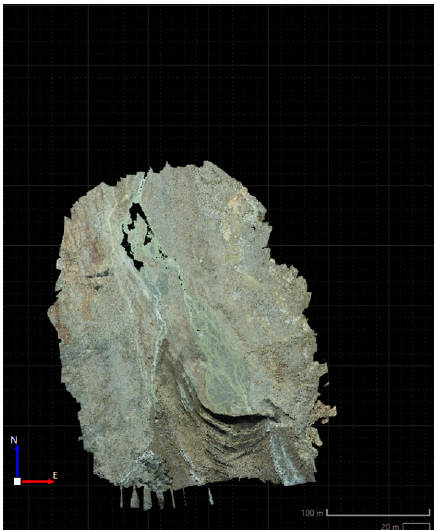
Figure 7. 2020 DPC - UAV track post-processing and direct georeferencing.